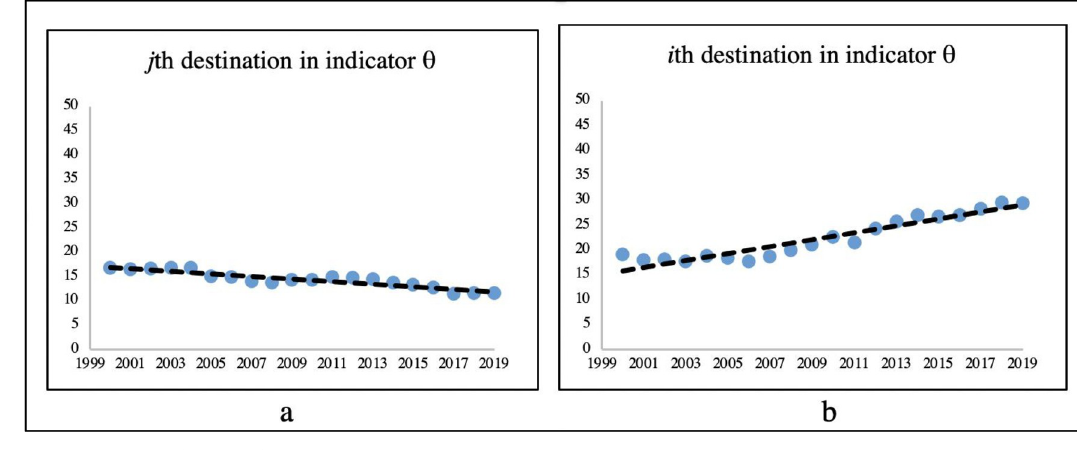
Fig 1. Negative and positive linear